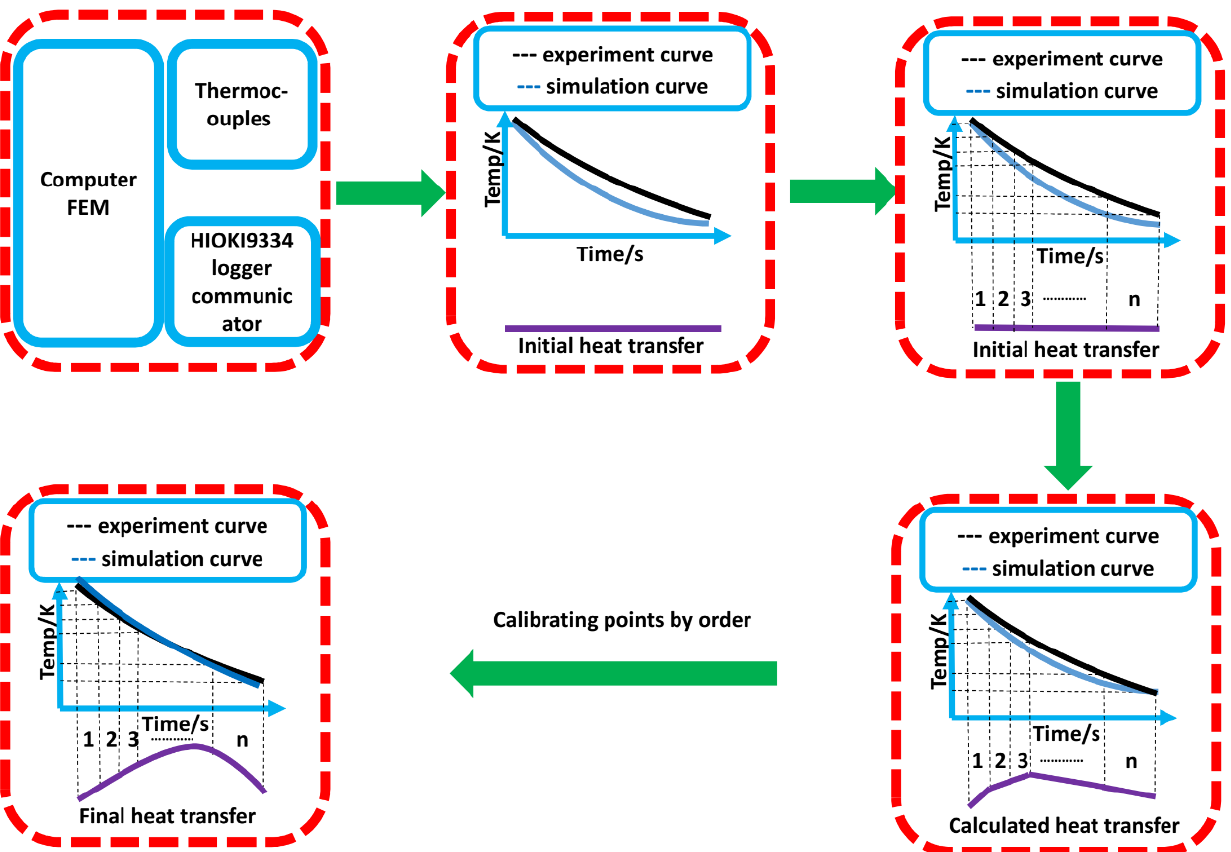
Figure 5. Schematic diagram of reverse seeking process for heat transfer coefficient.